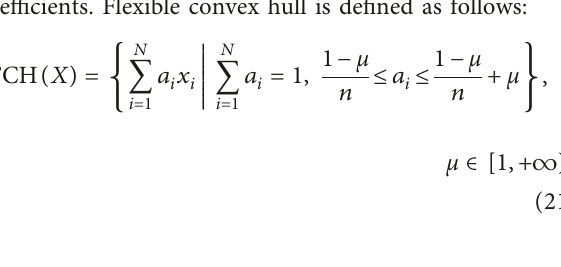
1 ( n ) generated by ASNBD.